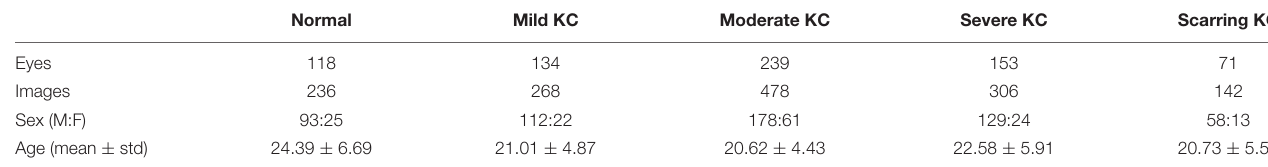
TABLE 1 | Demographic information for five groups in